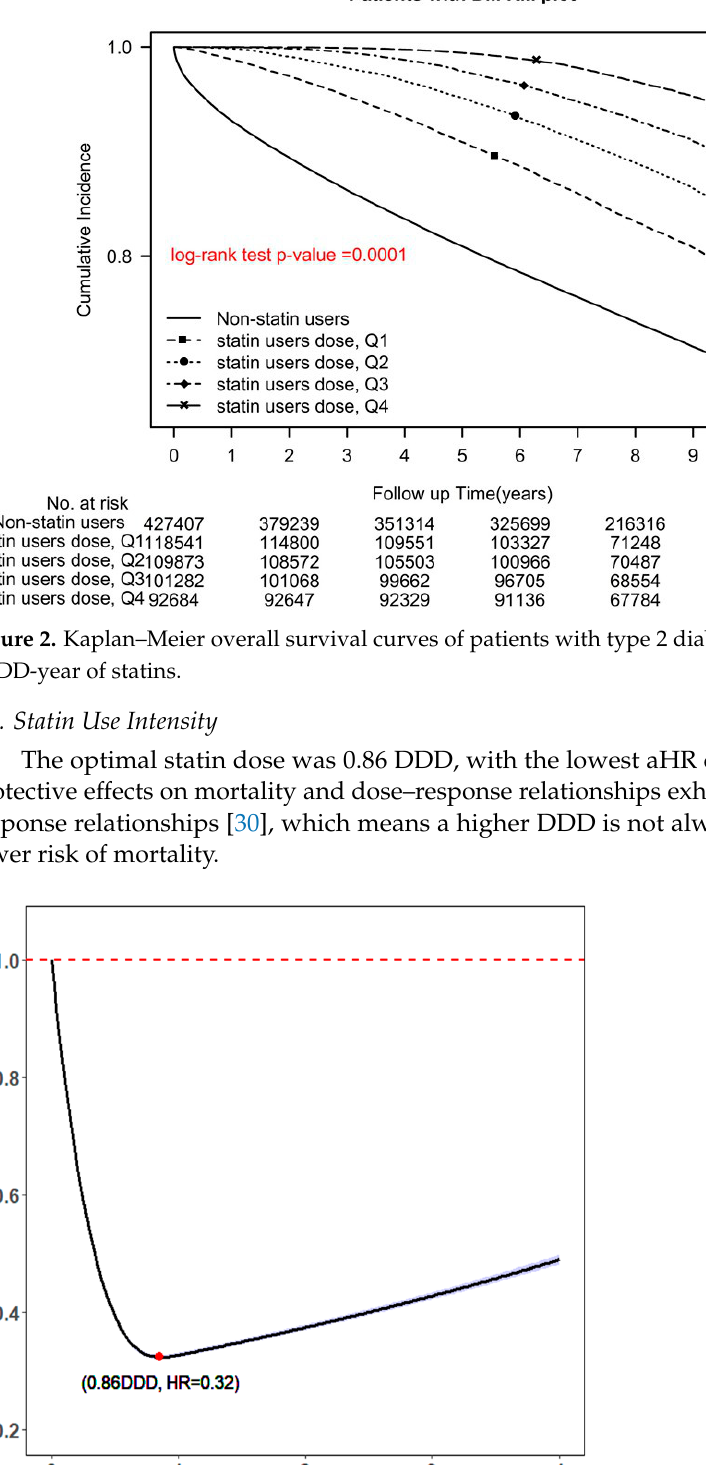
Figure 1. Kaplan–Meier overall survival curves of patients with type 2 diabetes who used di ff erent classes of statins.